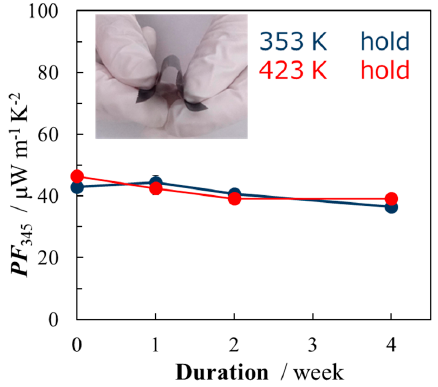
Figure 3. Durability of power factor ( PF ) at 353 K and 423 K of nano-PETT/PI/SG-CNT hybrid films (film thickness of 10 µm).